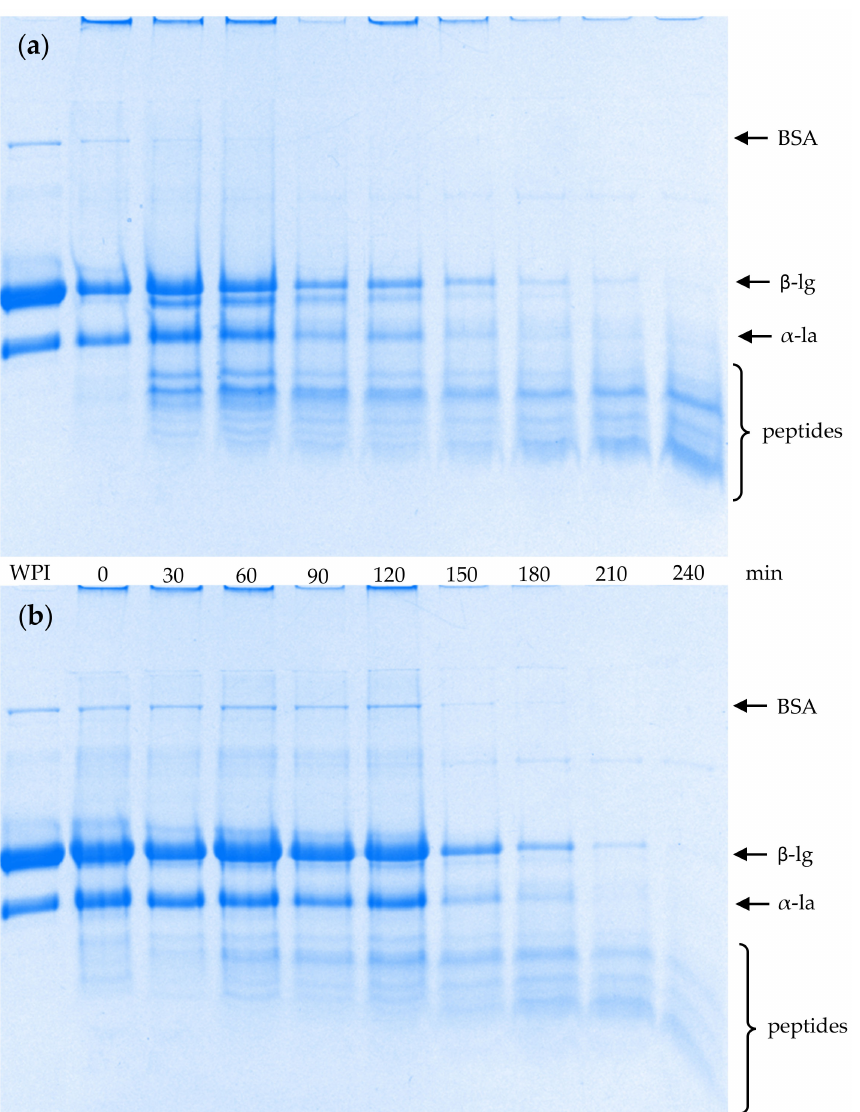
Figure 3. Tricine sodium dodecyl sulphate polyacrylamide gel electrophoresis patterns under reduc- ing conditions of emptied gastric digesta as a function of digestion time: ( a ) soft gel; ( b ) hard gel. WPI: whey protein isolate; BSA: bovine serum albumin; β -lg: β -lactoglobulin; α -la: α